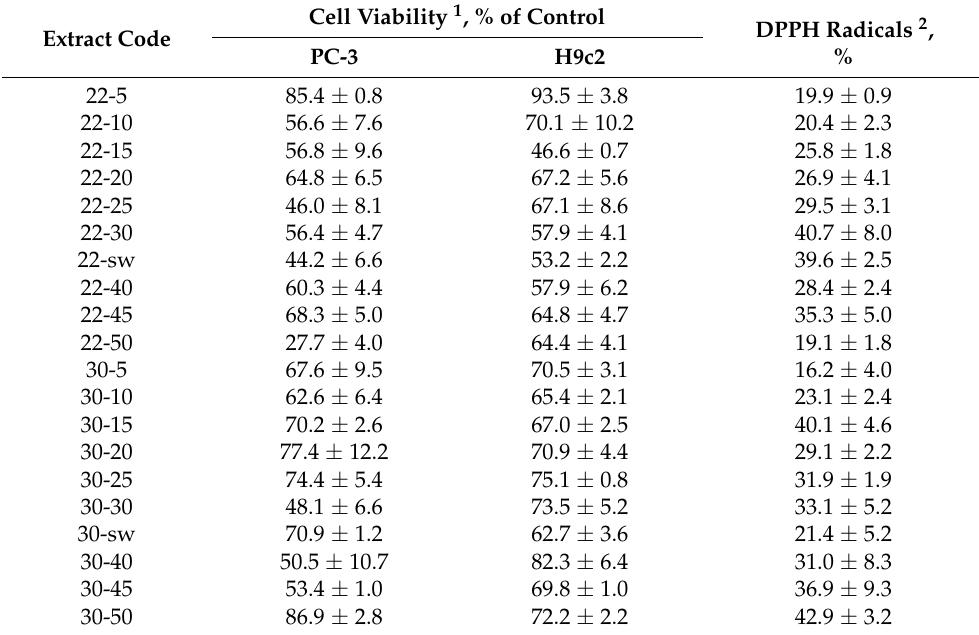
Table 3. The cytotoxic and radical scavenging activities of fungal extracts. Extract